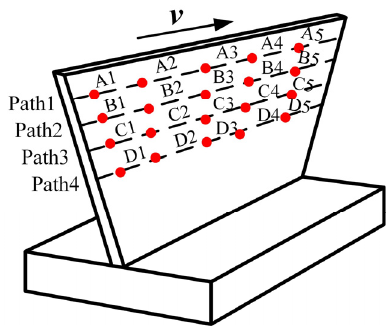
Figure 12. FRF prediction points in each path.